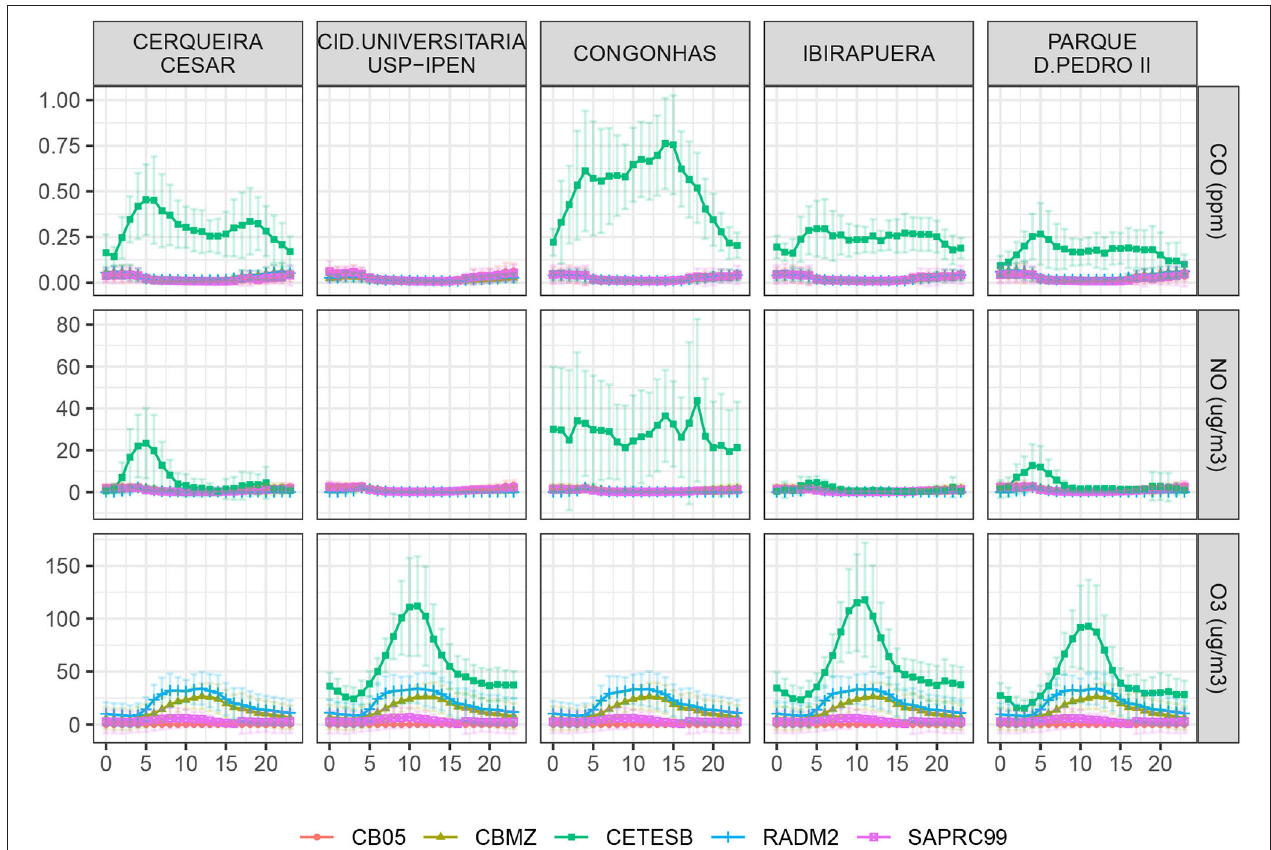
FIGURE 4 | Dournal cycles during March 2020 for CO, NO, and ozone, São Paulo. The points represent the averages and the vertical lines, the standard deviation.